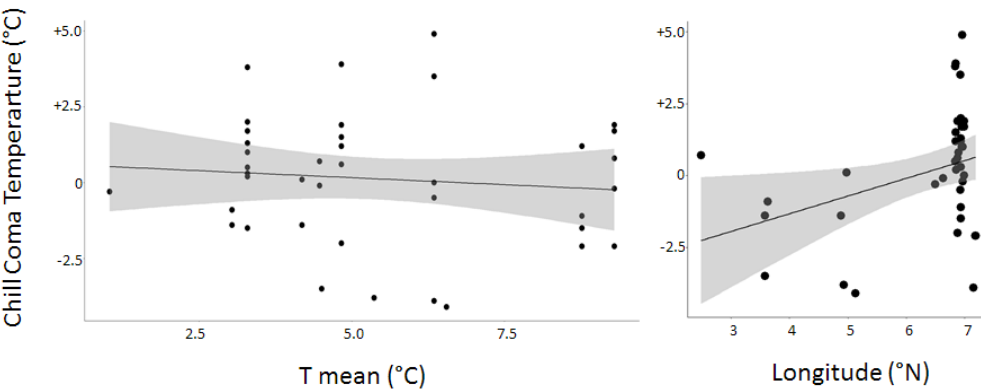
Figure 4. Influence of the climatic variable “Tmean” and the geographic variable “Longitude” on the chill coma temperature. The points, linear trend, and gray ribbon, respectively, represent the raw data and the predicted regression as well as the 95% confidence interval. The statistical significance of these two variables is indicated in the Table 3.